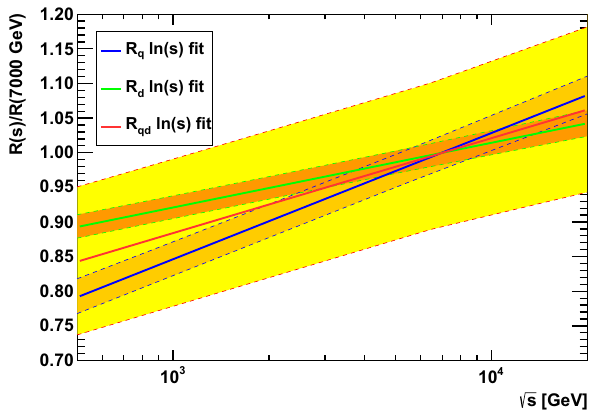
Fig. 21 Systematic error band on the R q ( s ) parameter as obtained by systematically shifting and fixing the best R q values up and down by one standard deviation at each energy where they are determined and then re-fitting all the other parameters, to account for the correlations between the parameters of the ReBB model. The central line indicates the best estimate for the quadratic in ln ( s ) polynomial for R q ( s )